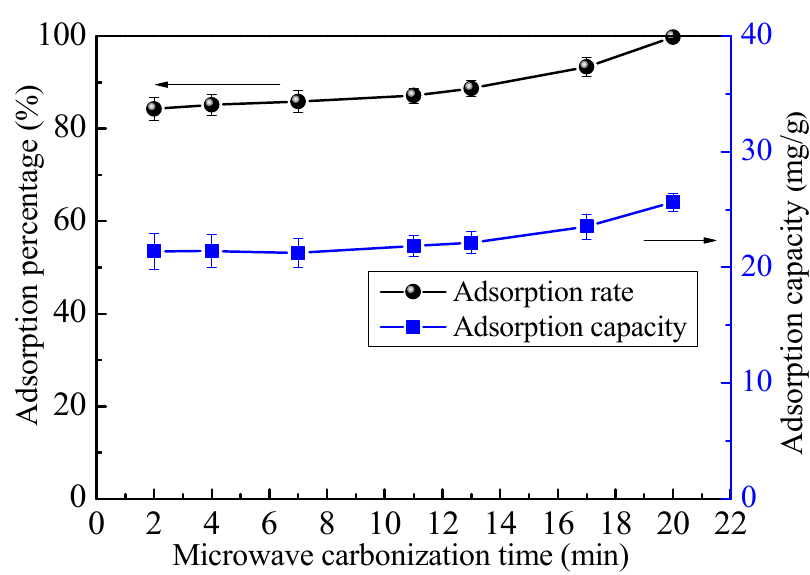
Figure 5. Effect of microwave treatment time on the adsorption of Pb(II).